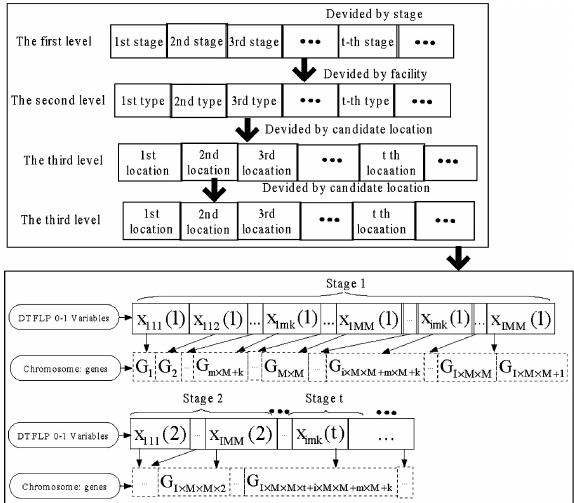
Fig. 3. Representation of the DDTFLPP in SA-based MOGA algorithm